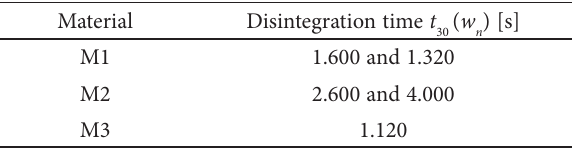
depending on water content for 30